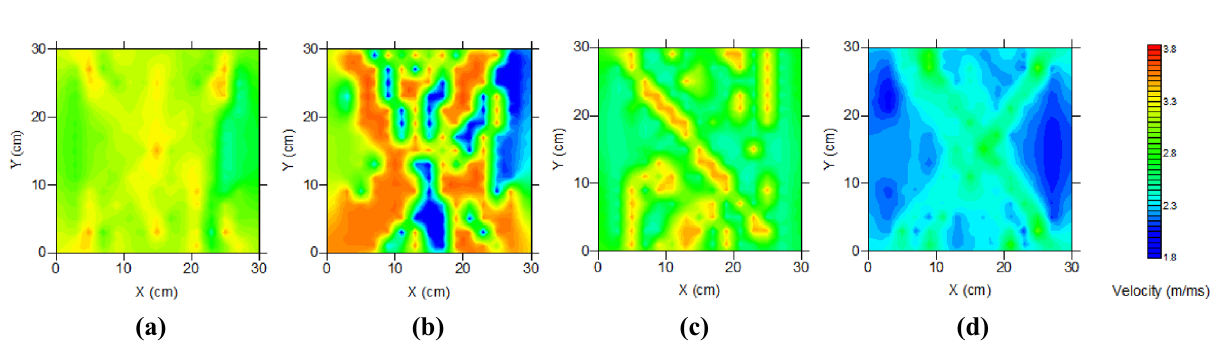
Figure 17. Ultrasonic image programs for different sections: ( a ) M 1 section, ( b ) M 2 section, ( c ) M 3 section, and ( d ) M 4